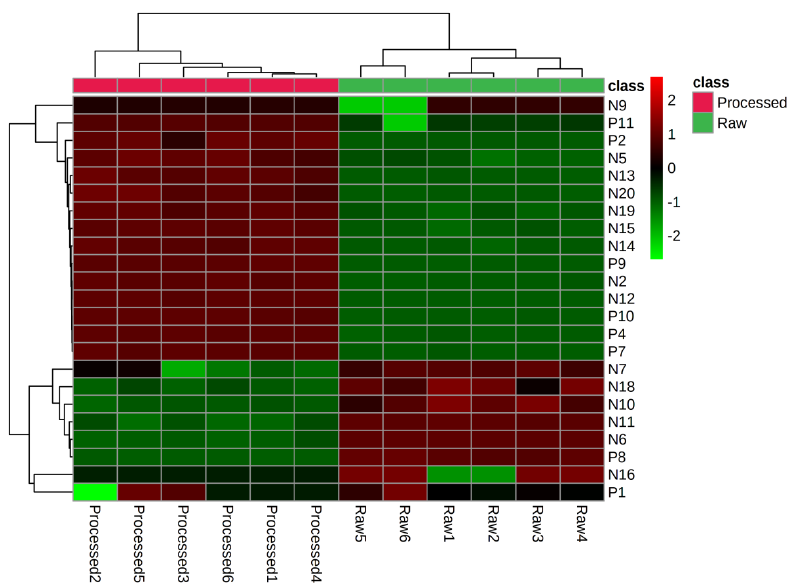
Figure 6. Cluster heat map of Sanguisorba officinalis L. before and after processing.